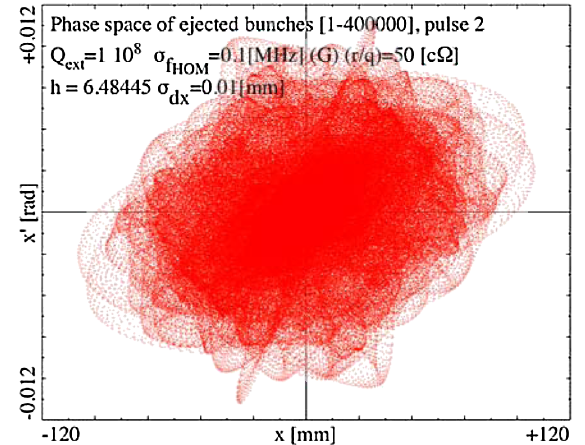
FIG. 48. (Color) Transverse phase-space image of the ejected bunches in x and x 0 . Q ext ¼ 10 8 , ð R=Q Þ? ¼ 50 (cid:2) , h I b i ¼ ¼ 100 kHz , 0.01 mm transverse injection jitter, 400 mA , (cid:1) (cid:3) f 2nd pulse. In reality the beam pipe does not cover such width, hence the beam would hit the beam pipe before.